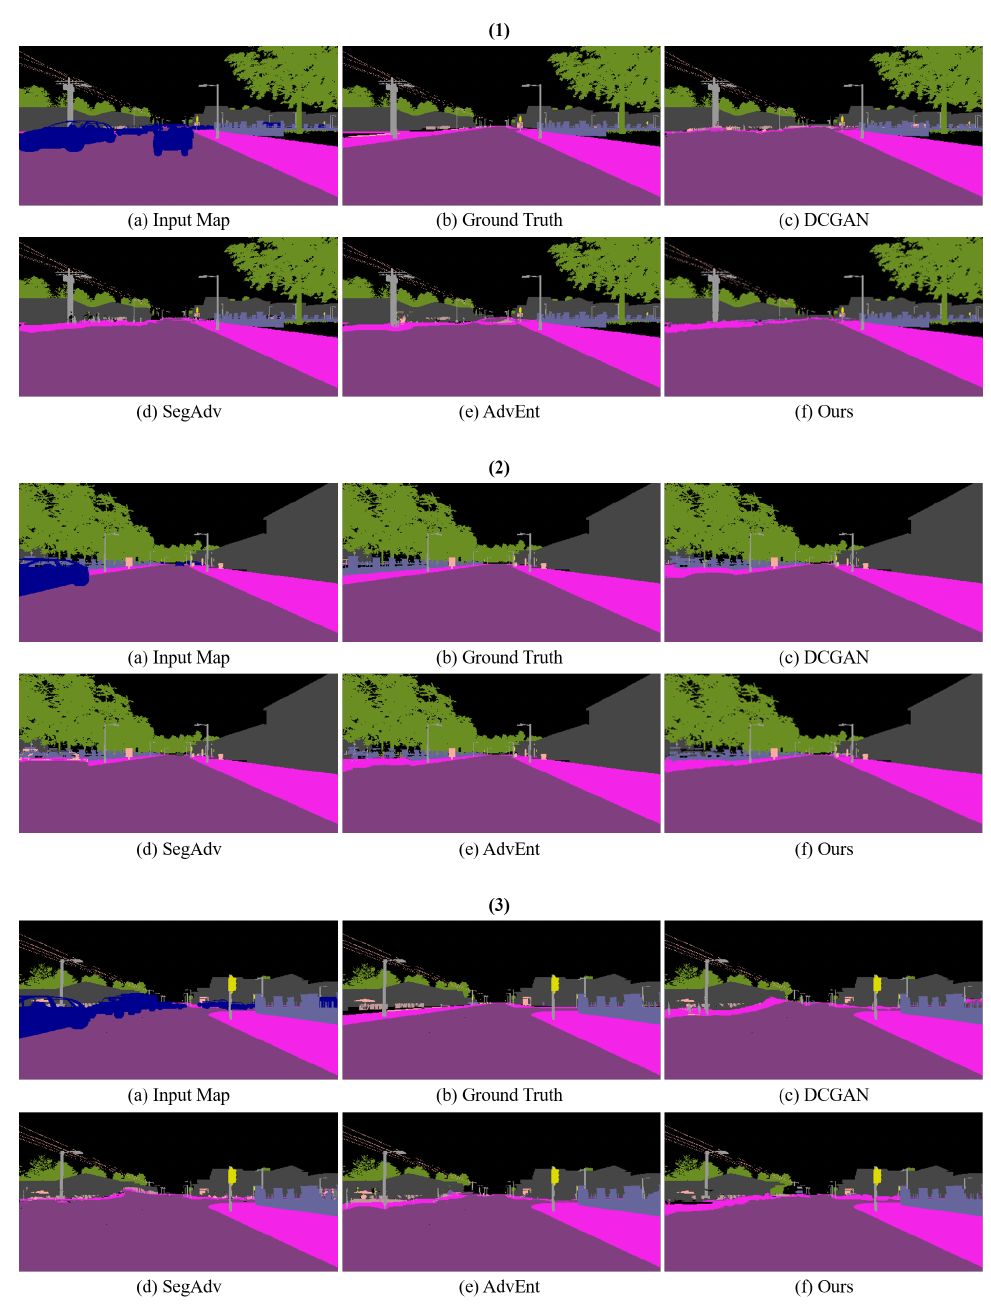
Figure 5. Unsupervised learning-based Media Integration and Communication Center Semantic Road Inpainting (MICC-SRI) qualitative results: ( a ) input map, ( b ) ground truth, ( c ) deep convolutional generative adversarial network (DCGAN) [20], ( d ) segmentation adversarial network (SegAdv) [29], ( e ) adversarial entropy network (AdvEnt) [27], and ( f ) semantic segmentation inpainting network